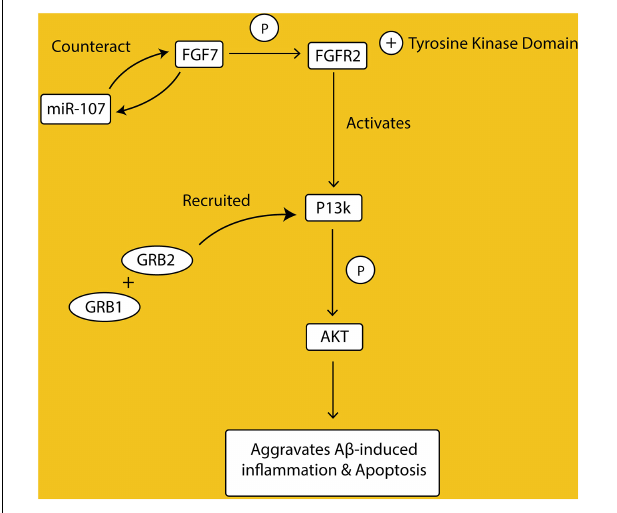
FIGURE 1 | Fibroblast growth factors (FGFs) bind to their receptors (FGFRs), activating their tyrosine kinase domain through phosphorylation. FGF/FGFR complex initiates the downstream signaling, by recruiting Growth factor receptor-bound protein 2 (GRB2) and Growth factor receptor-bound protein 1 (GRB1), which then activate Phosphoinositide 3-kinases (P13K) and phosphorylate Protein kinase B (AKT). Activation of P13K/AKT pathway exacerbates amyloid beta-induced inflammation and apoptosis. FGF7 has a binding site on MicroRna17 (miR-107) and overexpression of miR-107 reduces FGF7